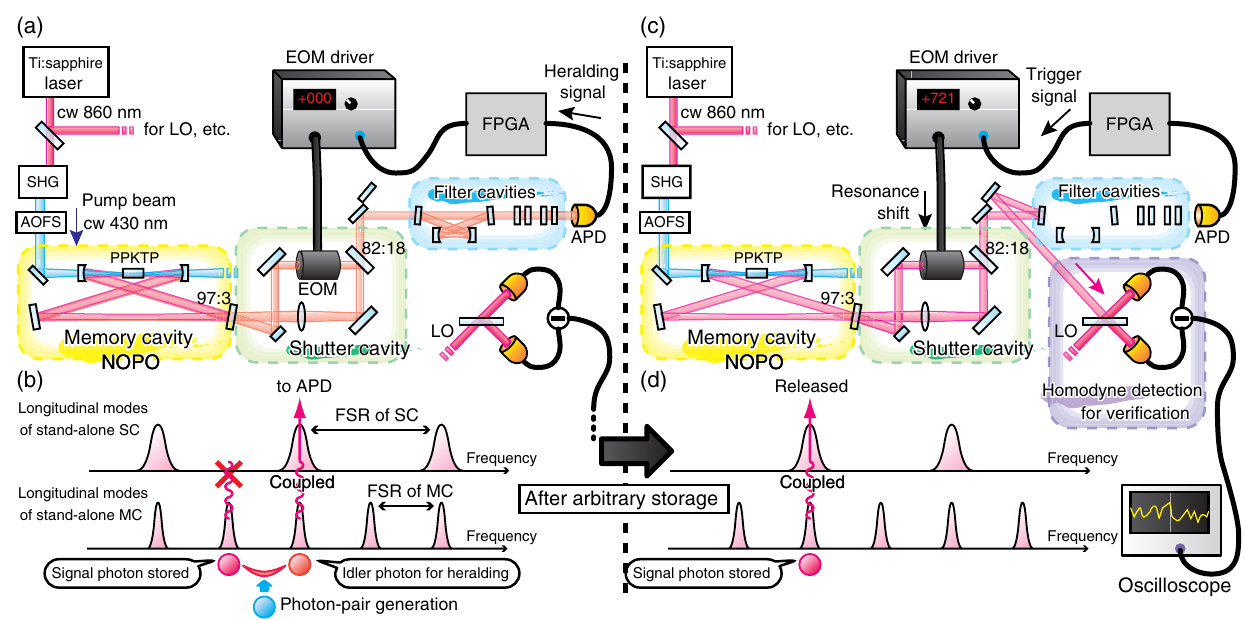
FIG. 1. Schematic diagrams of storage and release. (a) Experimental setup and beam paths at the storage stage. (b) Conceptual diagram in the frequency domain at the storage stage. (c) Experimental setup and beam paths at the release stage. (d) Conceptual diagram in the frequency domain at the release stage. Ti:sapphire, titanium-sapphire laser; cw, continuous wave; SHG, second harmonic generator; AOFS, acousto-optic frequency shifter; APD, silicon avalanche photodiode; and FPGA, field-programmable gate array to process logic